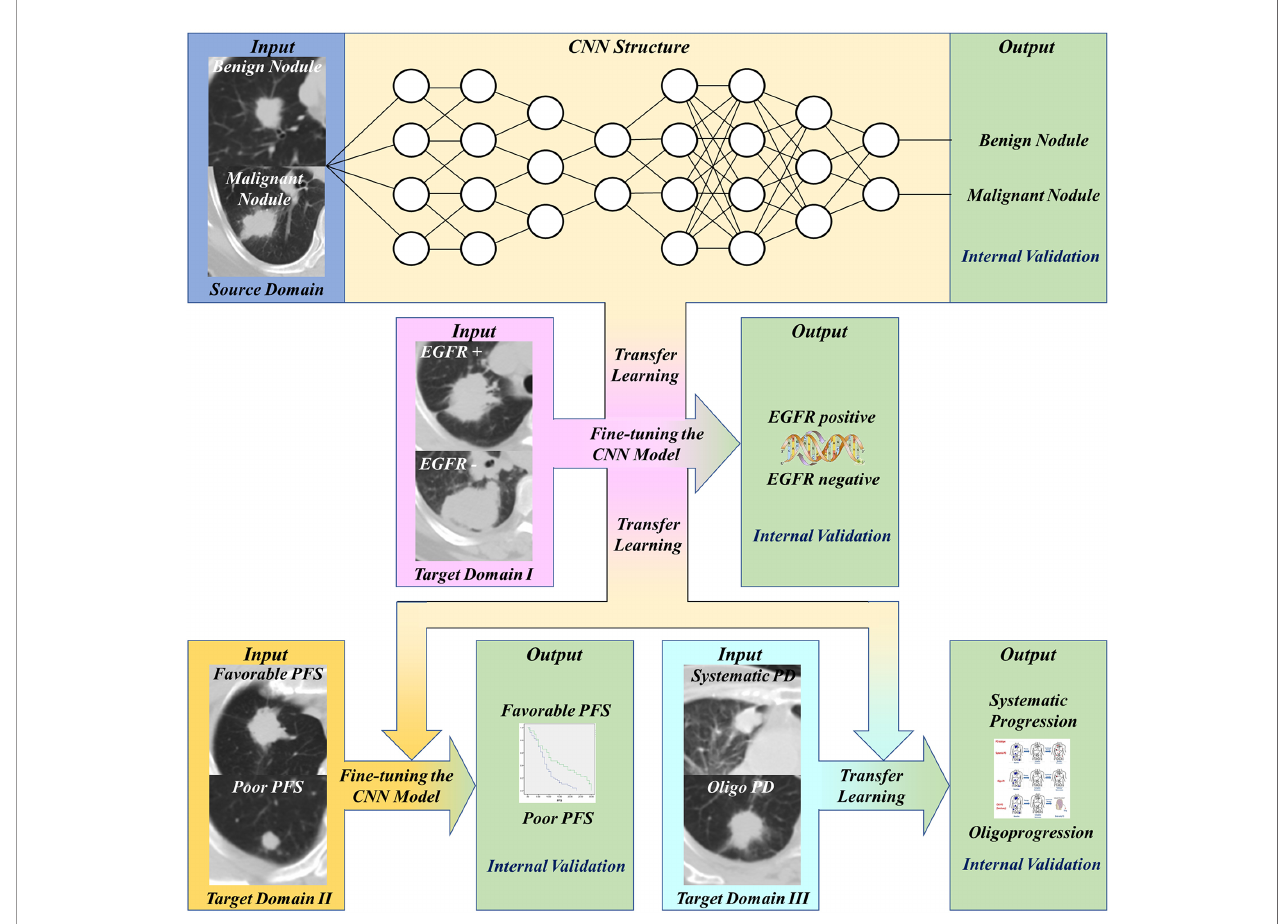
FIGURE 1 | Work fl ow of our work. First, transfer and fi netune the basic pulmonary nodule recognition model to EGFR prediction. Then, transfer the EGFR recognition model to PFS prediction and progression patterns